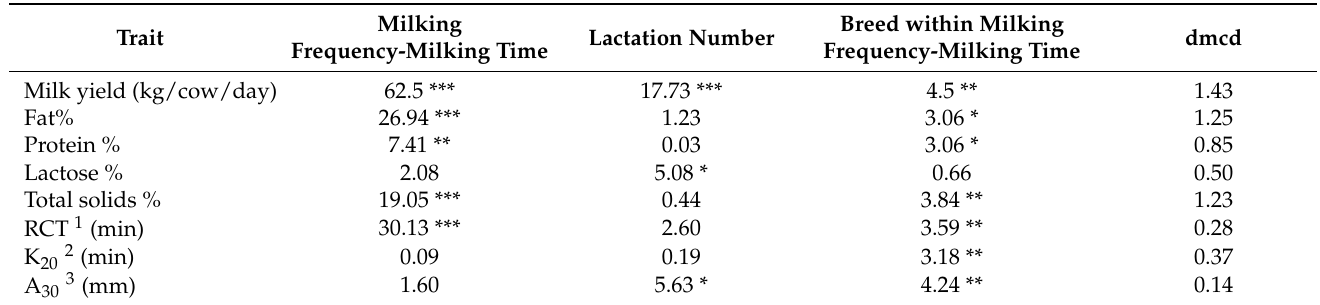
Table 3. The F-values for factors affecting milk composition and milk coagulation properties of cows milked once a day (OAD) and twice a day (TAD) sampled in the morning and afternoon during the late lactation in the 2020–2021 production